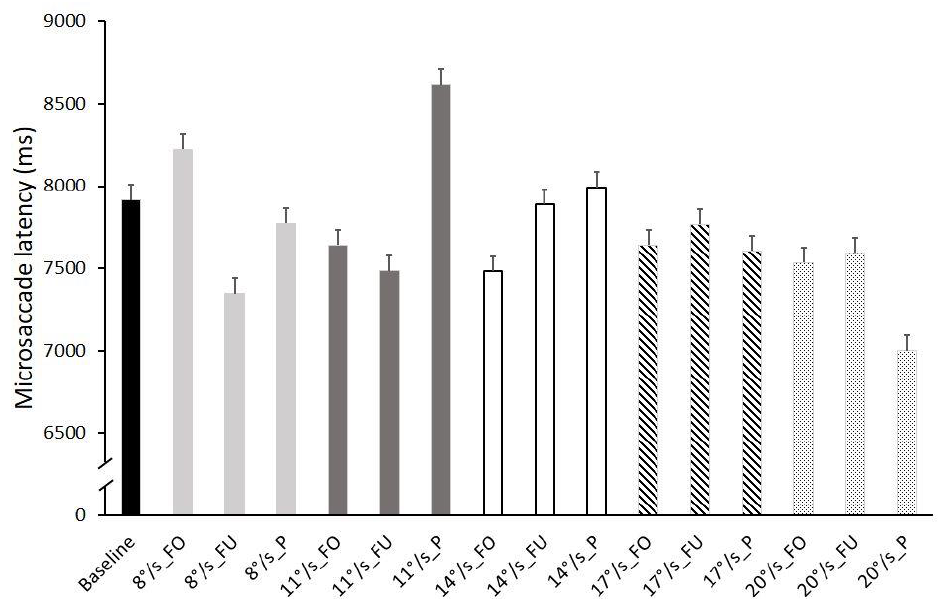
Figure 3. Frequency histograms of averaged microsaccade latency in all conditions. Black: baseline; light grey: speed 8 ◦ /s; dark grey: speed 11 ◦ /s; white: speed 14 ◦ /s; dashed lines: speed 17 ◦ /s; dotted lines: speed 20 ◦ /s; FO: fovea; FU: full field; P: periphery. Data are reported as mean ± SE.